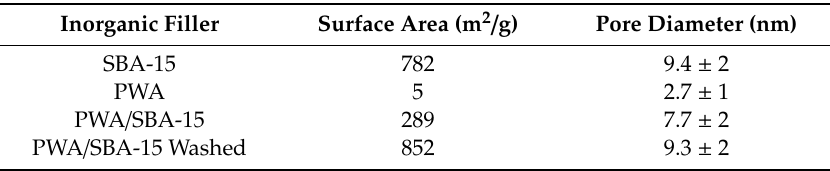
Table 1. Textural properties of inorganic